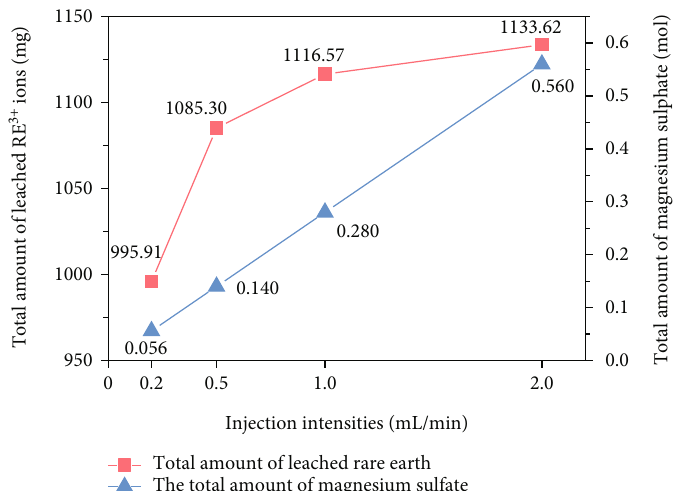
Figure 12: The total amount of leached RE 3+ ions and the total amount of magnesium sulphate under di ff erent injection intensities.